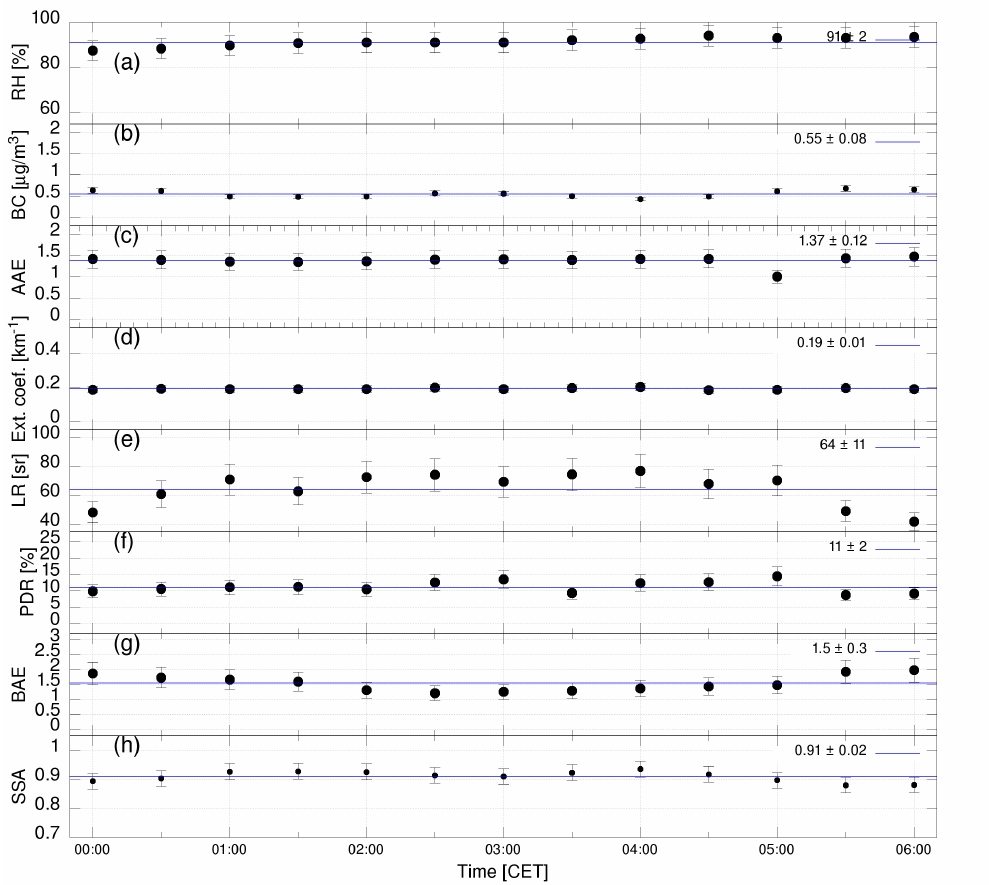
Figure 8. Temporal variation of the retrieved aerosol observables on 17 November 2017 between 00:00 and 06:00 CET. ( a ) RH, ( b ) BC concentration and ( c ) AAE between 470 and 950nm were obtained at Otlica site, and ( d ) extinction coefficient, ( e ) LR, ( f ) PDR at 355nm and ( g ) Backscatter BAE between 355 and 1064nm were obtained from lidar measurements at the same height with Otlica site, while the SSA at 370 nm ( h ) was calculated combining lidar and aethalometer measurements. All the data was re-sampled over 30min. Error bars of each points indicate the uncertainties of corresponding parameters. Horizontal lines indicate the mean value of each corresponding